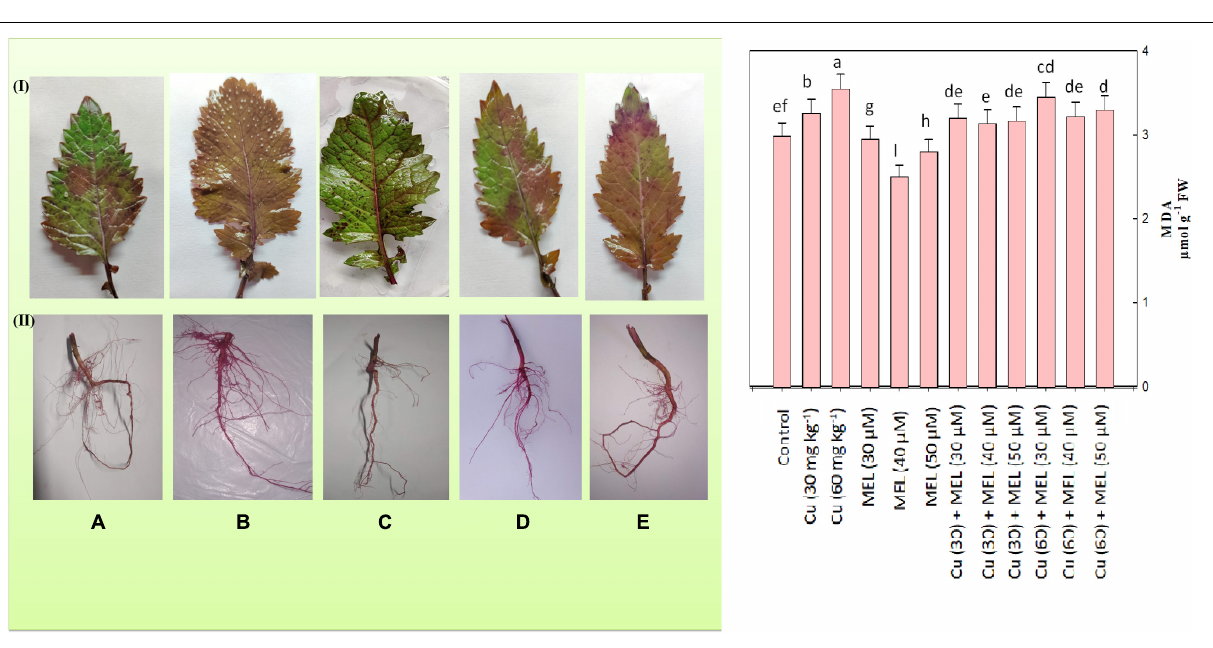
FIGURE 3 | Malondialdehyde content and histochemical localization of lipid peroxidation in the (I) leaves and (II) roots of 45-day-old B. juncea (L.) cv. Varuna raised with Cu and/or sprayed with MEL. (A) Control, (B) Cu 60 mg kg − 1 , (C) MEL µ M, (D) Cu 30 + MEL (40 µ M), and (E) Cu 60 + MEL (40 µ M). Data show the mean ± standard error, and same letters indicate no significant difference at P <